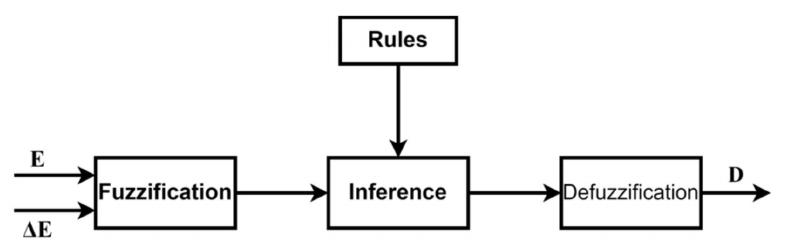
Figure 18. Block diagram of fuzzy control.